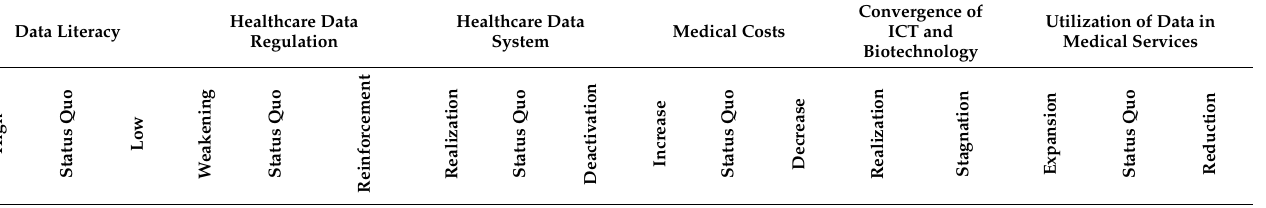
Table A2. Distance between Spectra (Expert Evaluation